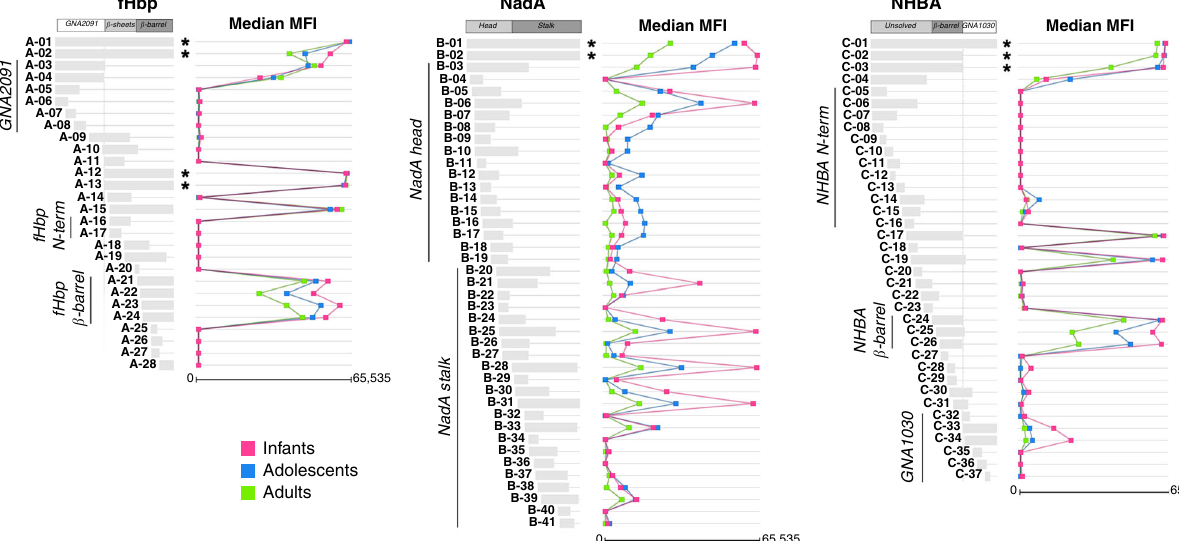
Fig. 2 Protein microarray analysis unveils the reactivity pro fi le of 4CMenB antigens. Each horizontal light grey bar represents a single protein or protein fragment spotted in the microarray for GNA2091-fHbp (A-01 to A-28), NadA (B-01 to B-41) and NHBA-GNA1030 (C-01 to C-37). The corresponding coloured squares on their right show the median antibody binding reactivity against that fragment in all tested sera from human vaccines, grouped by age: green squares for adult subject sera, blue squares for sera from adolescents, and pink squares for sera from infants. Stars indicate the full-length or whole fusion forms of each